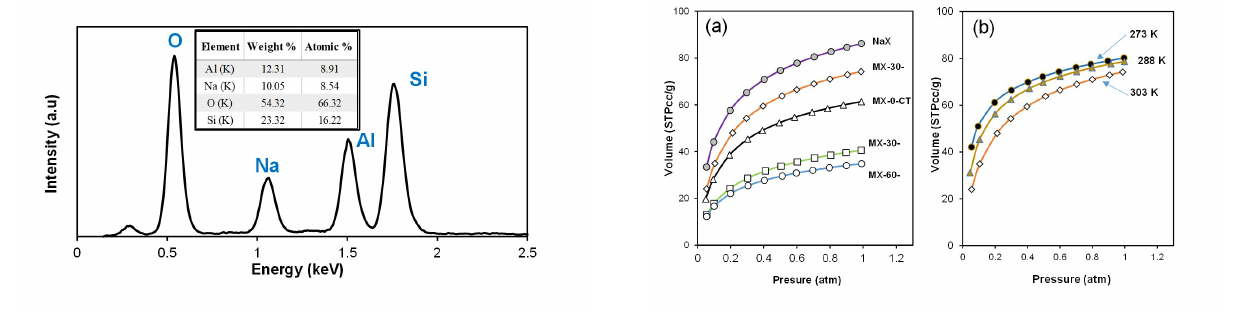
Fig. 2. EDX Pattern of